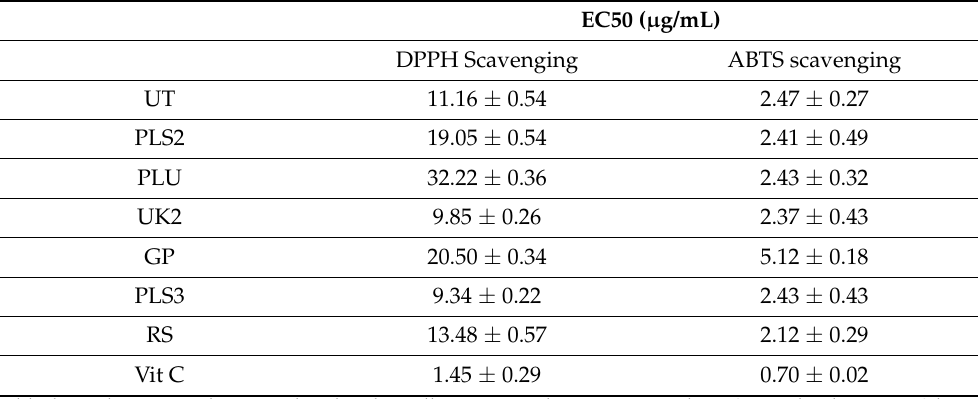
Table legend: UK2—Ukraine, Khmelnitsky Village; UT—Ukraine, Ternopil; PLS2—Poland, Lower Silesia; PLS3—Poland, Lower Silesia; PLU—Poland, Lublin Region; GP—Greece, Parga; RS—Russia, Saratov Oblast; Vit C—vitamin